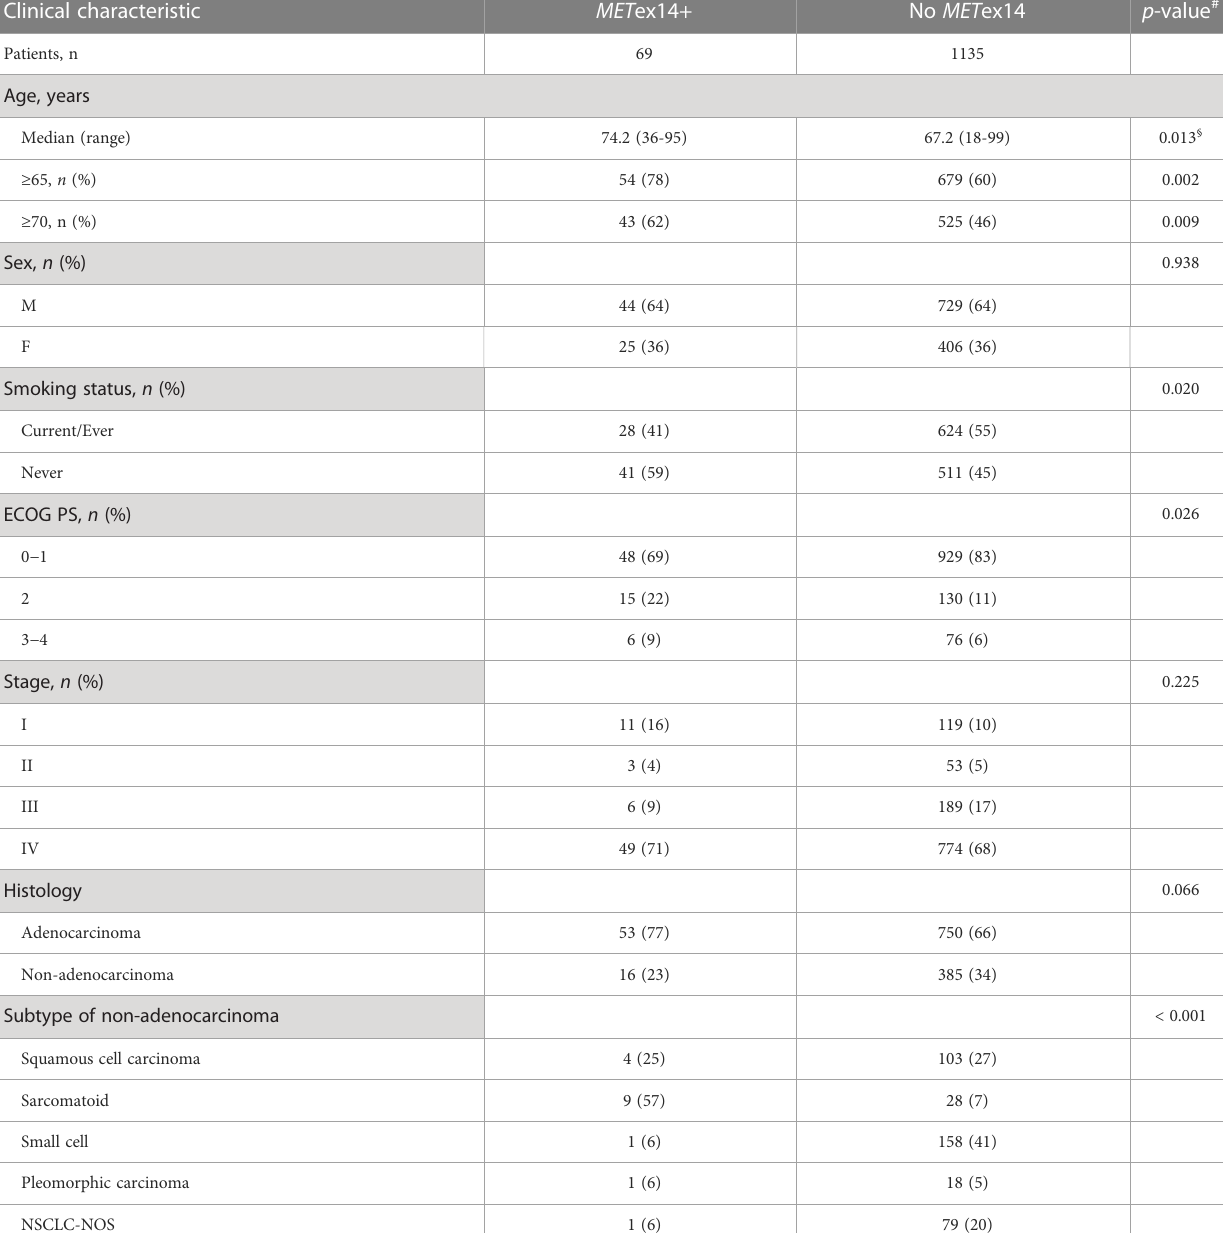
TABLE 1 Clinical characteristics of lung cancer patients harboring tumors with ( n = 69) and without ( n = 1135) the MET ex14 mutation. Clinical characteristic MET ex14+ No MET ex14 p -value